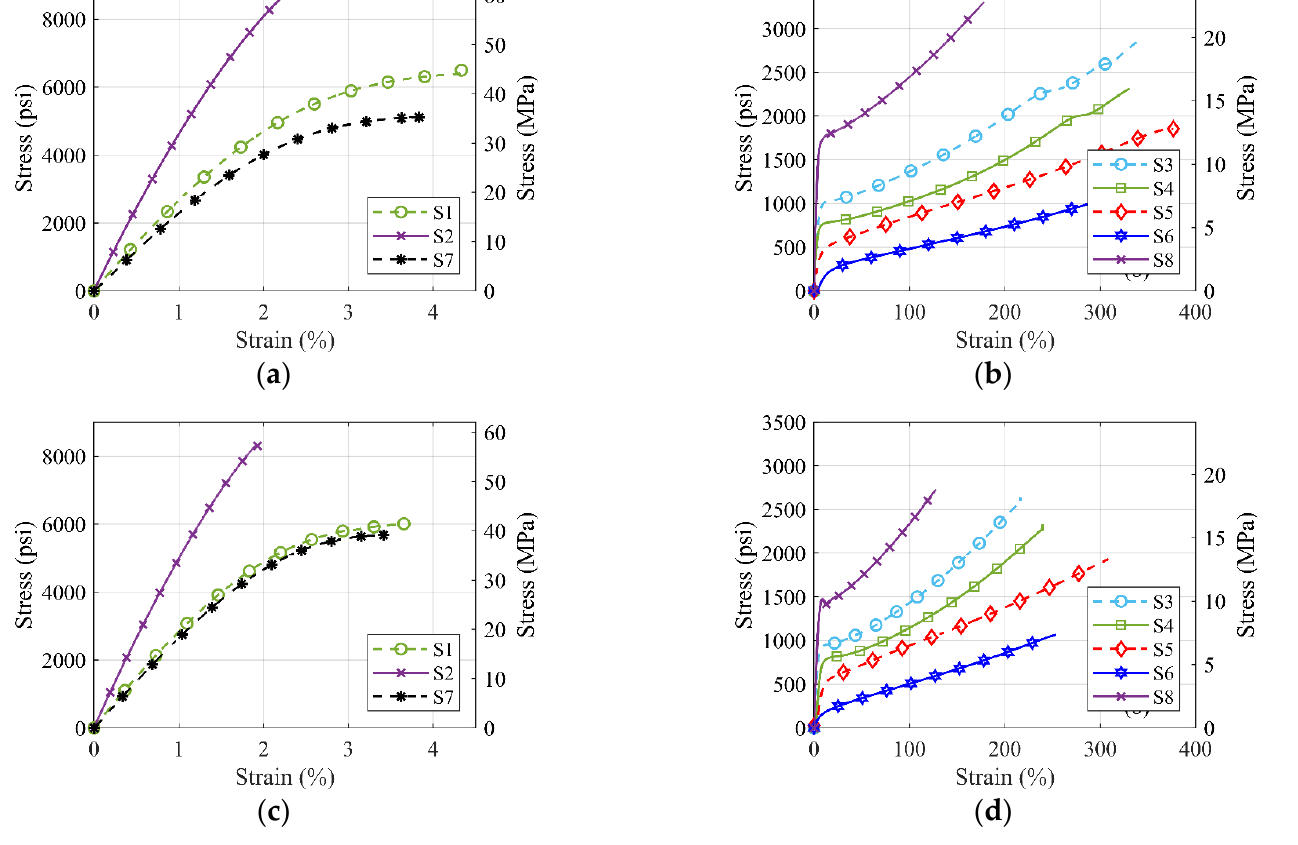
Figure 6. Comparison of monotonic tensile stress-strain response of ( a ) ASTM die type I coupons of S1, S2, and S7 material, ( b ) ASTM die type I coupons of S3, S4, S5, S6, and S8 material, ( c ) ASTM die type IV coupons of S1, S2, and S7 material, ( d ) ASTM die type IV of S3, S4, S5, S6, and S8 material.